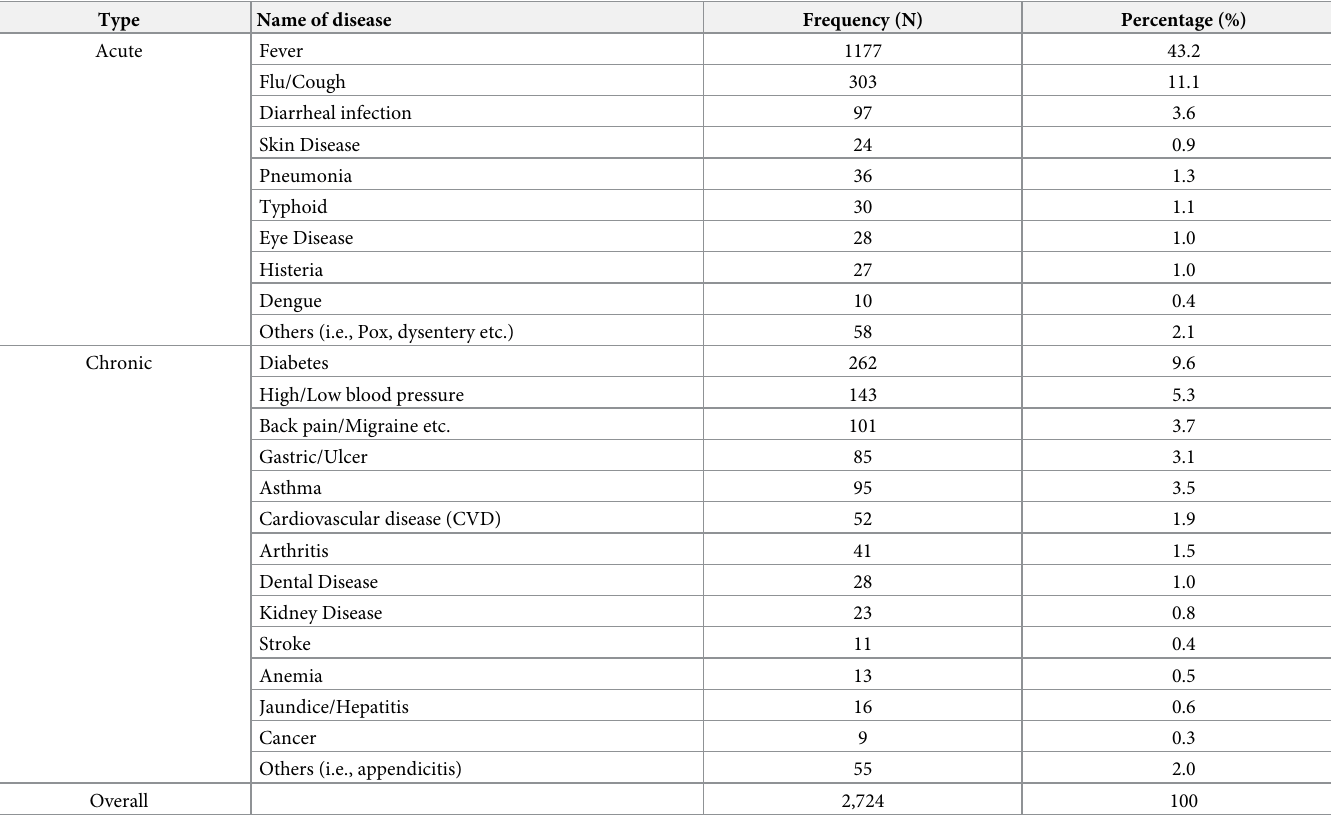
Table 2. Self-reported illness during last 30 days preceding to this